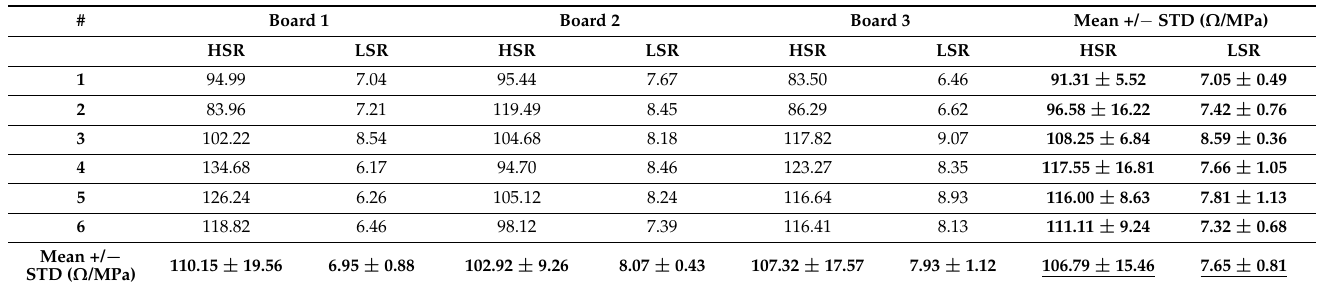
Figure 5 Change in resistance (  R [ Ω ]) vs. an increasing load per sensor dimension and replicas. Figure 5. Change in resistance ( ∆ R [ Ω ]) vs. an increasing load per sensor dimension and replicas. Three figures signify three different manufactured sample boards. Three figures signify three different manufactured sample boards. Table 4. Mean sensitivity and standard deviation for the high sensitivity region (HSR) and low sen- Table 5. Mean sensitivity and standard deviation for the high sensitivity region (HSR) and low sitivity region (LSR). sensitivity region